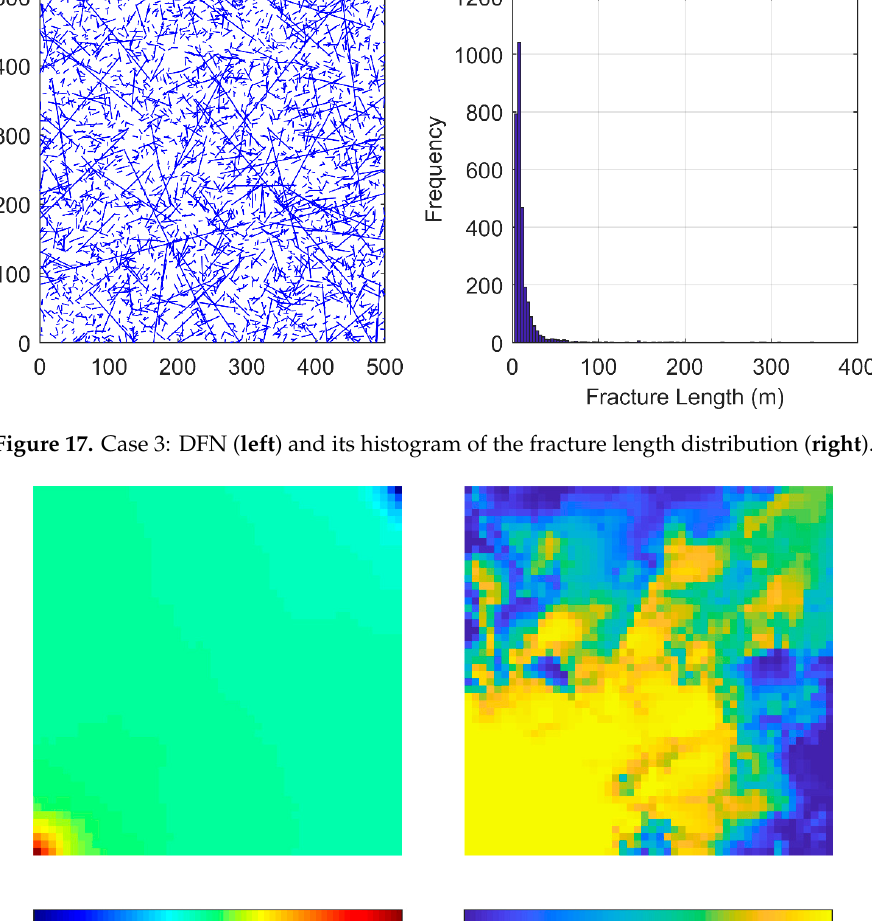
Figure 20. Case 3: absolute error of tracer concentration for Ups-CP ( left ) and Ups-LP ( right ).